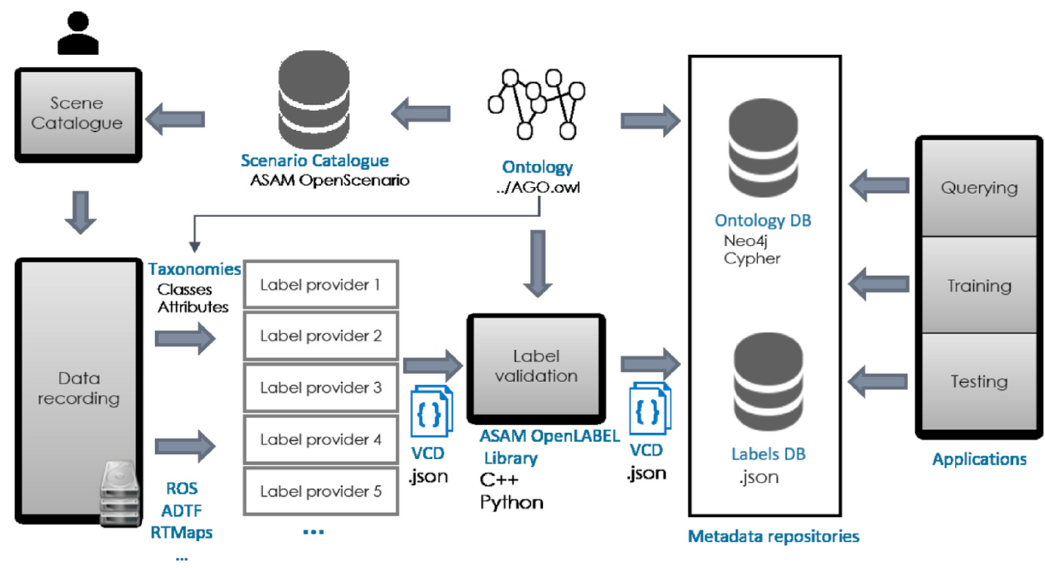
Figure 9. Using AGO to specify taxonomies and configuration files before the labeling stage to produce semantically compliant content.